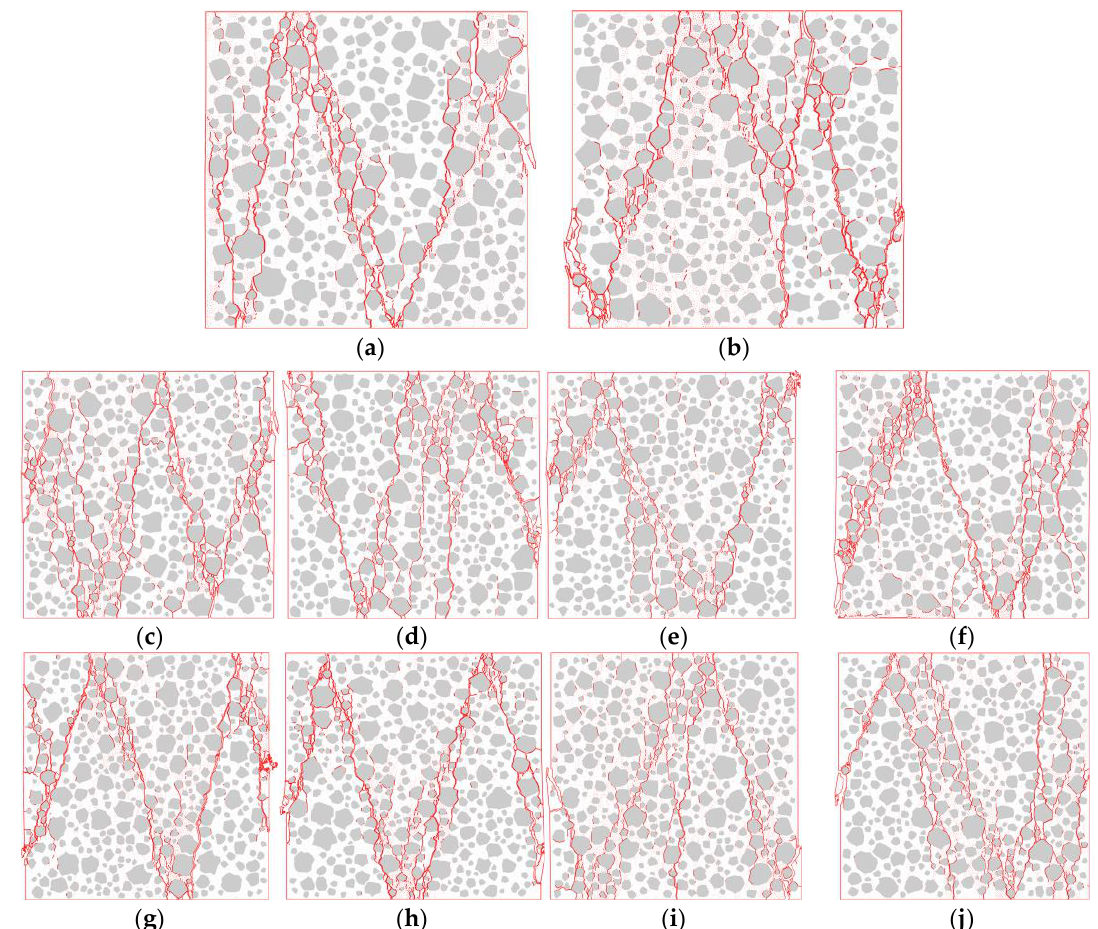
Figure 11. Failure modes of the specimens with different aggregate distributions under compression